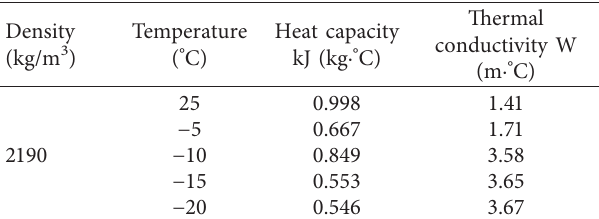
Table 2: Thermophysical parameters of sand at different